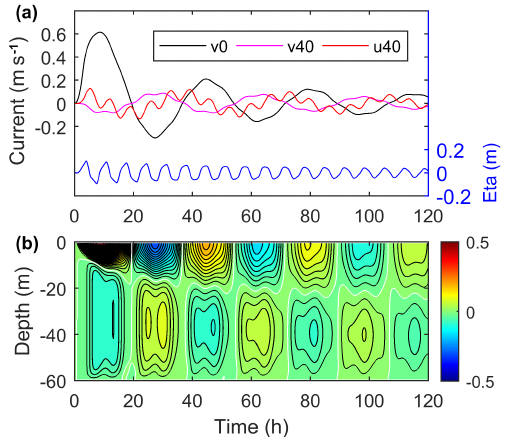
Figure 3. (a) Time series of velocities and elevation at x = 100km. “v0” and “v40” mean the northward velocity ( v) at depths of 0 and 40m, and “u40” is the eastward velocity ( u) at 40m. (b) Contours of v at x = 100km. The white lines denote the value of zero, and the contour interval is 0.02ms − 1